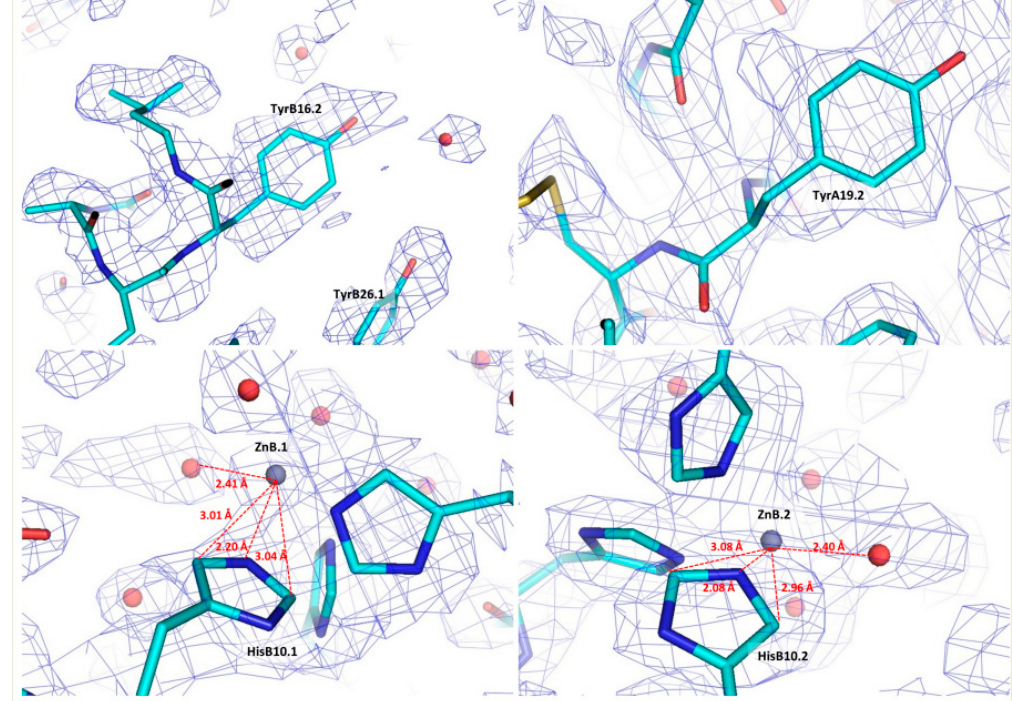
Figure 5. Regions of the final structural model of bovine insulin in stick representation and the corresponding OMIT map contoured at 1 σ . The cyan, blue and red colours in the stick representation illustrate C, N and O atoms of different amino acids, while Zn atoms and water molecules are denoted as grey and red spheres, respectively. The closest distances between the two Zn ions and the neighbouring His residues and water molecules are indicated in red dashed lines (Reproduction of Figure 10 from reference [70]. Reproduced with permission of the International Union of Crystallography).